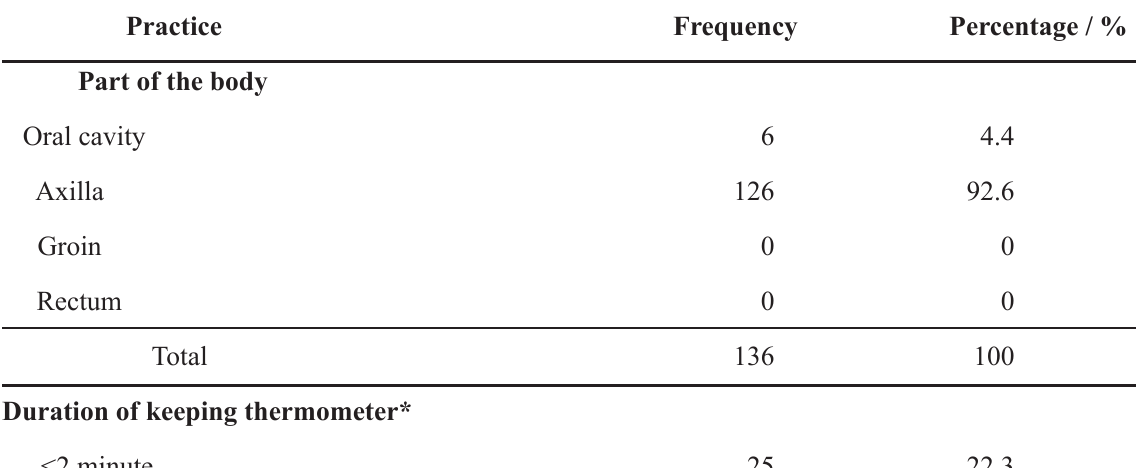
Table 1 Method used to detect the fever